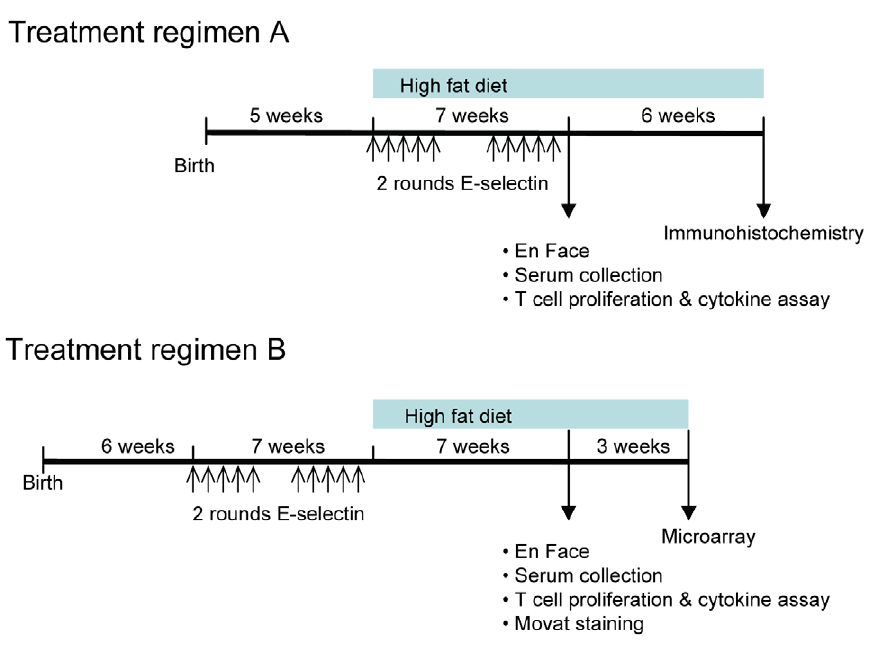
Figure 1. Treatment regimens. Mice received 2 rounds of intranasal delivery of E-selectin or PBS. The 2 rounds of intranasal delivery were separated by 2 weeks and each round of intranasal delivery was composed of 5 doses (PBS or 5 m g E-selectin per dose) with 1 dose (10 m l) every other day. In regimen A (N=10 per group), we initiated the intranasal delivery of solutions and the high-fat diet simultaneously. In regimen B (N=25 per group), we gave the mice intranasal delivery of solutions prior to initiating the high-fat